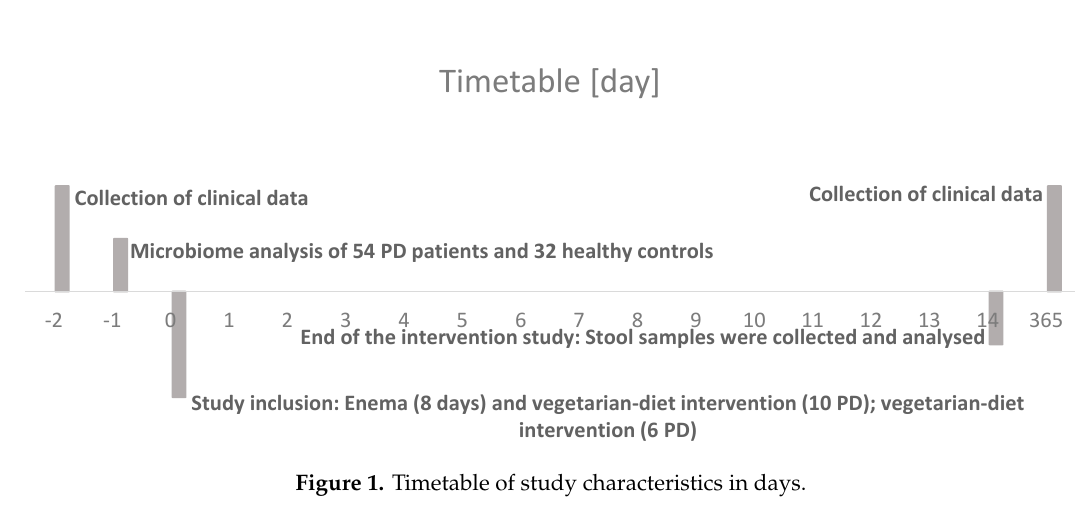
Figure 1. Timetable of study characteristics in days.